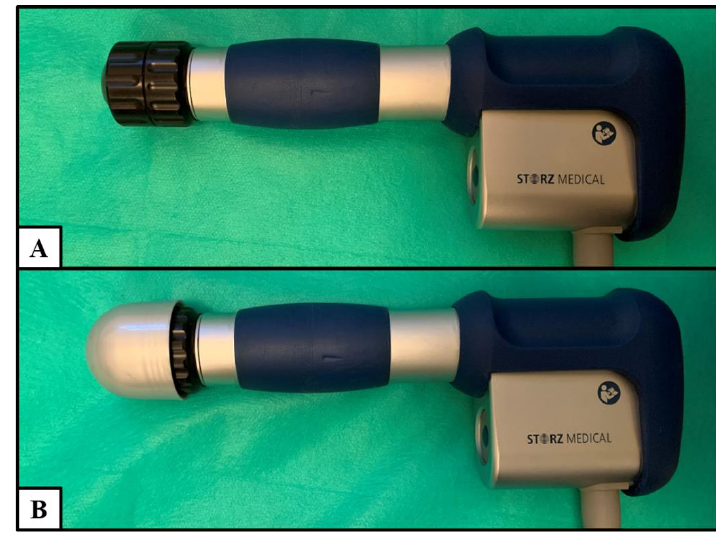
Figure 3. Radial extracorporeal shock wave applicators: ( A ) the standard rESWT applicator and ( B ) sham-rESWT applicator with polyethylene cap to provide placebo interventions.